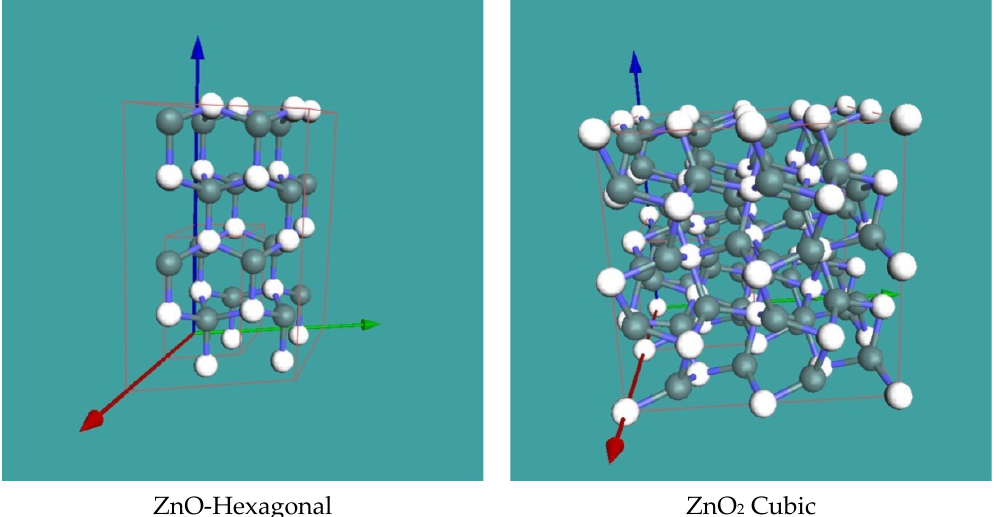
Figure 10. 3D representation of the two possible zinc oxides. The white spheres are Zn atoms.